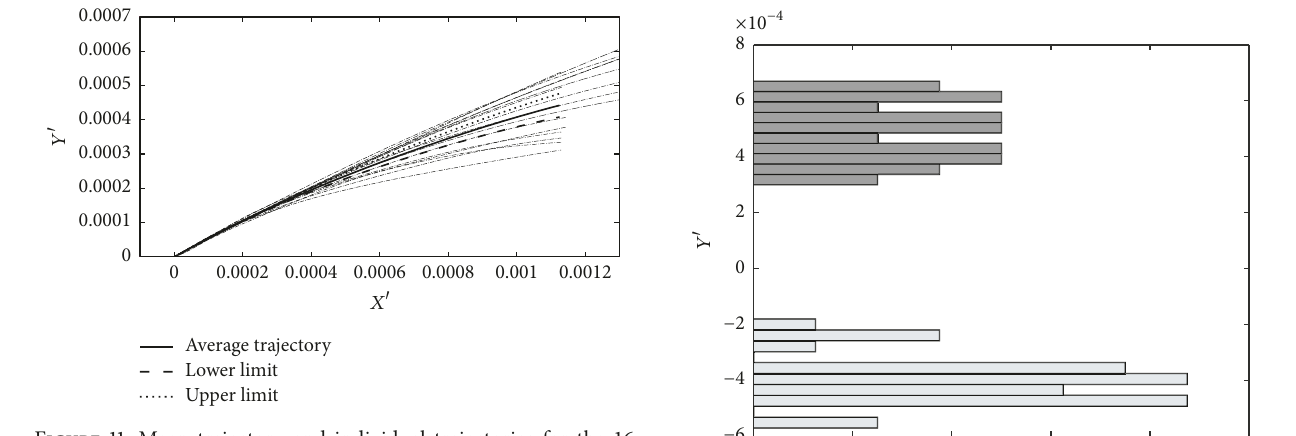
Figure 11: Mean trajectory and individual trajectories for the 16 runs with an initial positive angle of attack for the plate.